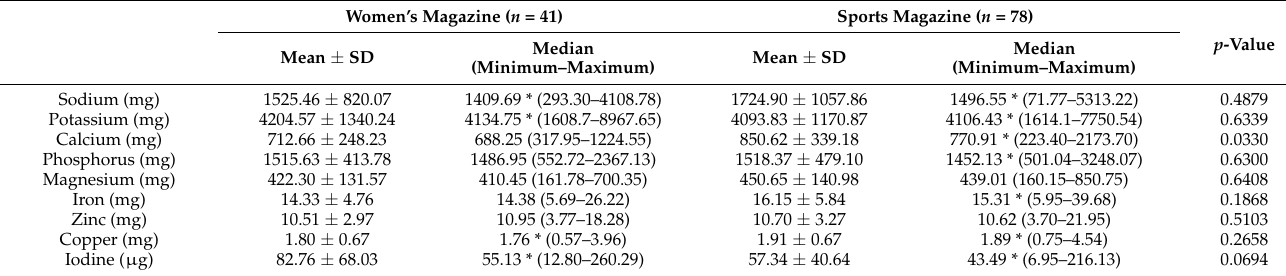
Table 2. The mineral intake within the assessed single-day menus, stratified by type of magazine, for the diets published in the women’s magazine and the diets published in the sports magazine.